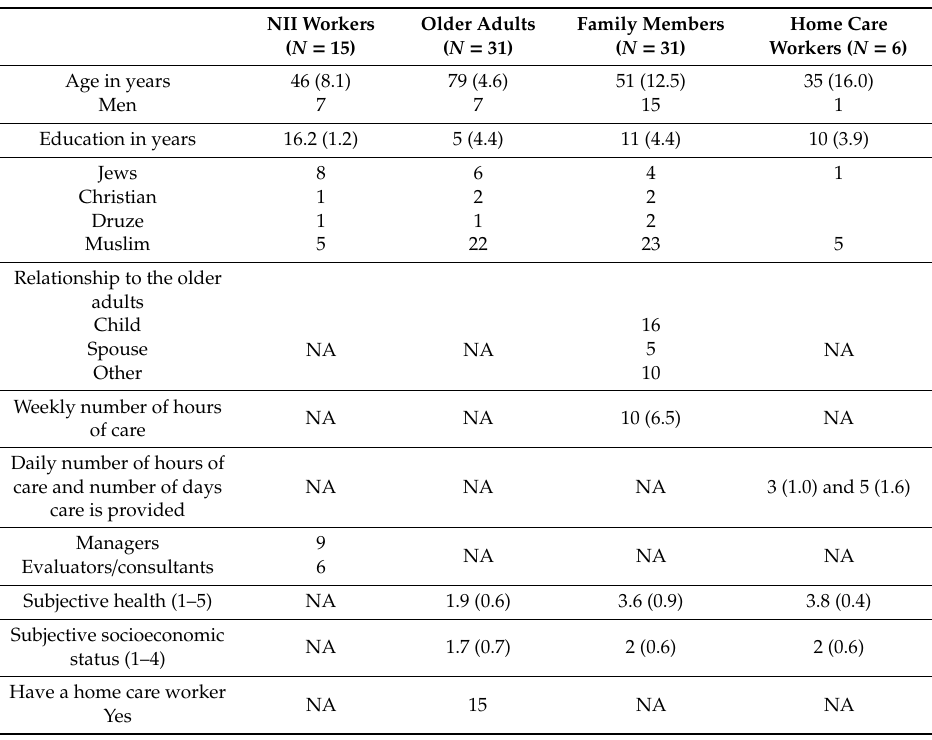
Table 1. Demographic characteristics of the